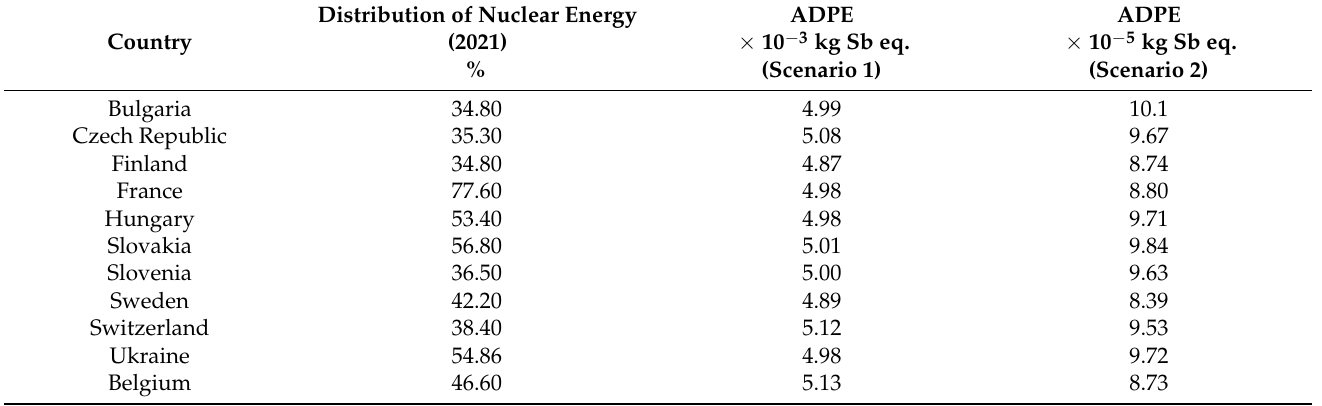
Table 7. ADPE values for different countries using electricity mix (scenario 1) and nuclear electricity of 100% (scenario 2) inputs at the production stage (with professional database 2021 of GaBi 8.0